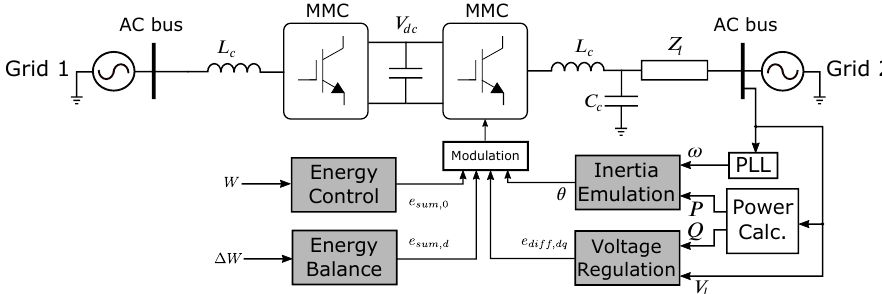
Figure 5. VSM general control scheme applied to an MMC-HVDC